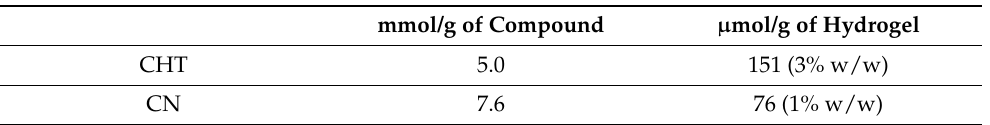
Table 3. Concentration of reactive groups (amino and aldehyde groups, respectively) per g of CHT and CN and per g of